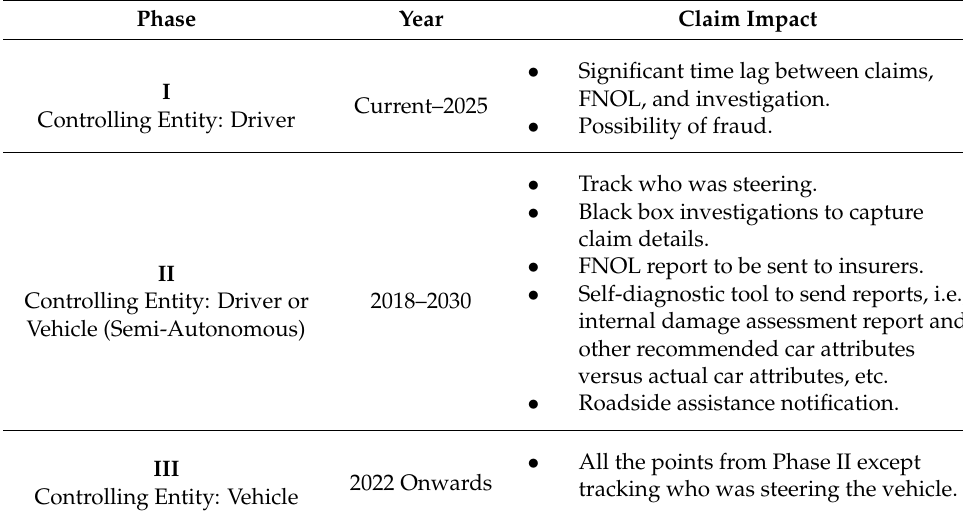
Table 3. Claims impact over time adapted from